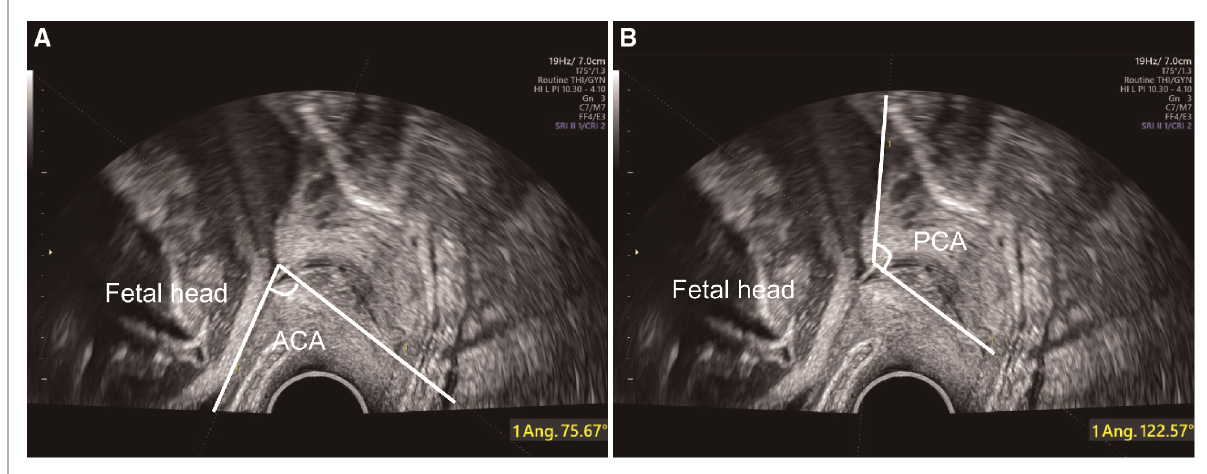
FIGURE 2 Antepartum ultrasound assessment with TVS for delivery prediction. ACA ( A ) and PCA ( B ) are assessed at the junction of the line measuring the cervical length and anterior or posterior uterine wall. TVS, transvaginal ultrasonography; ACA, anterior cervical angle; PCA, posterior cervical